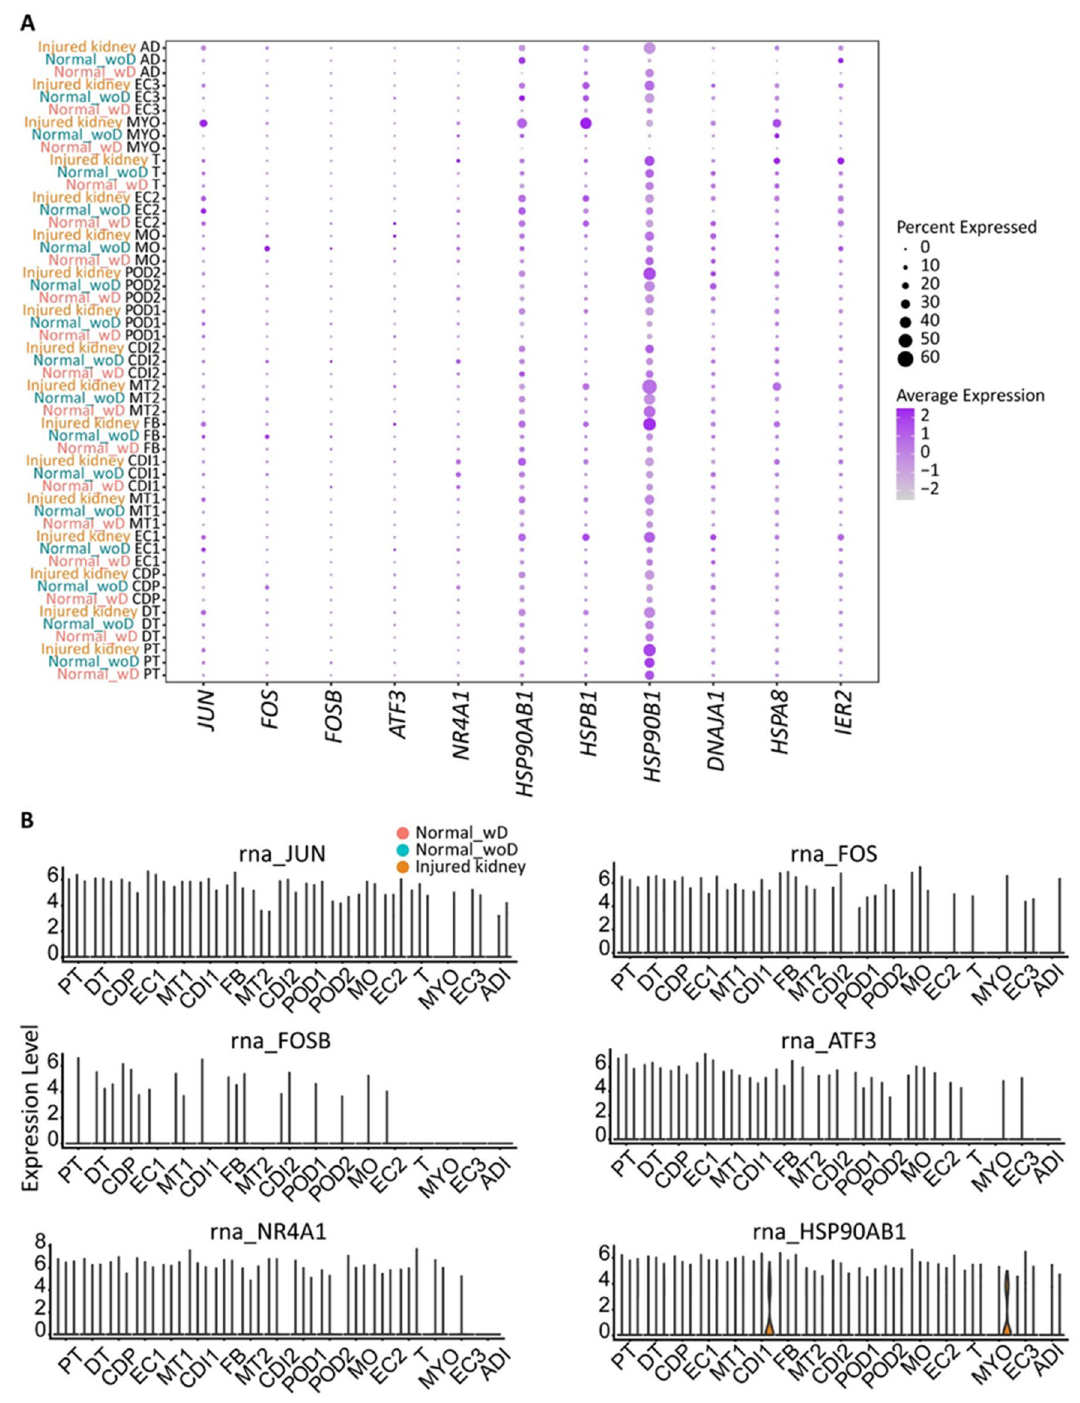
Figure 6. Analysis of cellular stress response. ( A ) Gene expression of stress response markers from isolated kidneys with (Normal_wD) and without douncing (Normal_woD and Injured kidney). Kidneys without douncing were isolated following our described protocol. The size of the dot represents the percentage of cells in the corresponding cluster expressing the marker and the color of the dot represents the average gene expression value. ( B ) RNA expression levels by cluster. Cell clusters: ADI adipose cell, CDI1 colleting duct intercalated, CD12 collecting duct intercalated 2, CDP collecting duct principal, DT distal tubule, EC1 endothelial cell 1, EC2 endothelial cell 2, EC3 endothelial cell 3, FB fibroblast, MO monocyte, MT1 mixed tubule 1, MT2 , mixed tubule 2, MYO myocyte, POD1 podocyte 1, POD2 podocyte 2, PT proximal tubule, T T